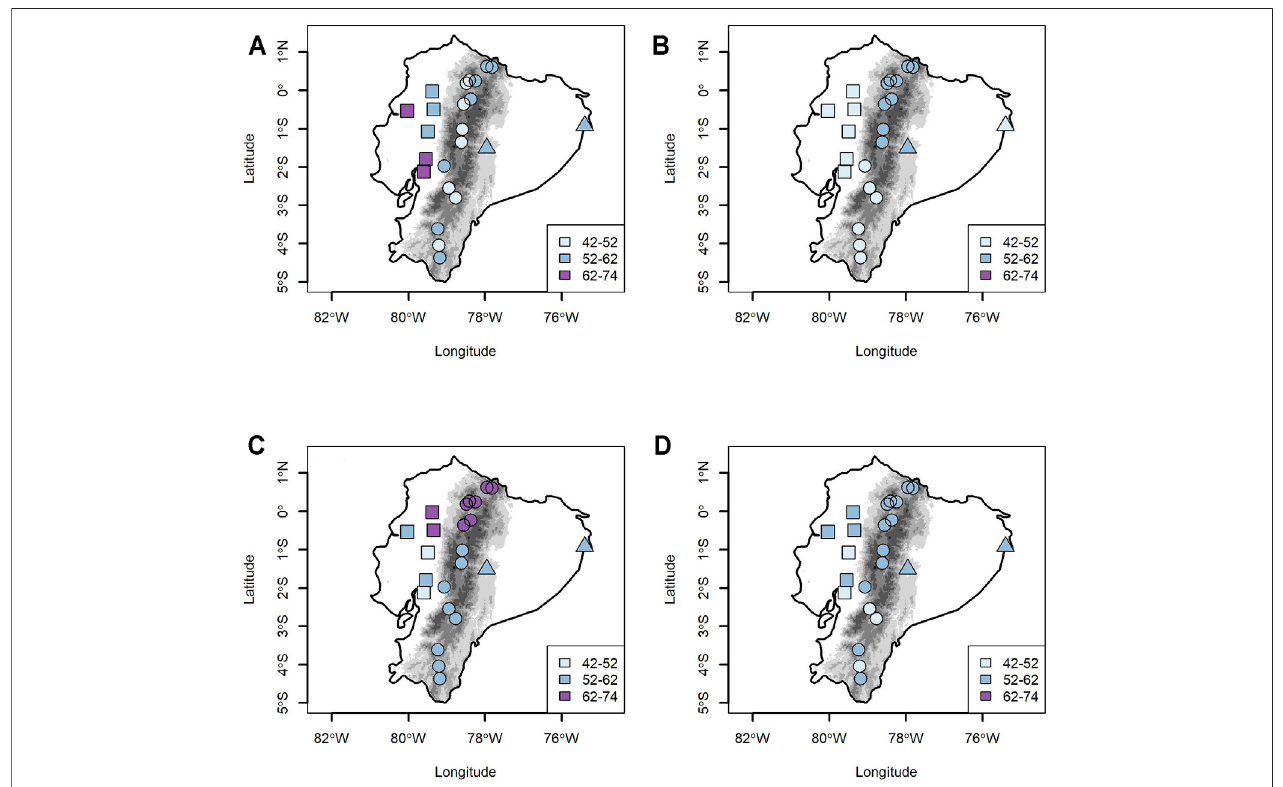
FIGURE6| Highriskday(HRD)meanvaluefortheperiod2011 – 2040fromCSIRO (A) ,GISS (B) ,andIPSL (C) . Figure6D istheensemblethatexplainsthemedian from three WGCMs.